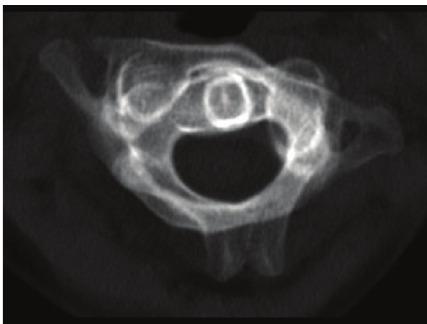
Figure 1: The initial axial CT scan of C1-C2 demonstrates rotatory displacement, CT-MIP (maximum intensity projection).